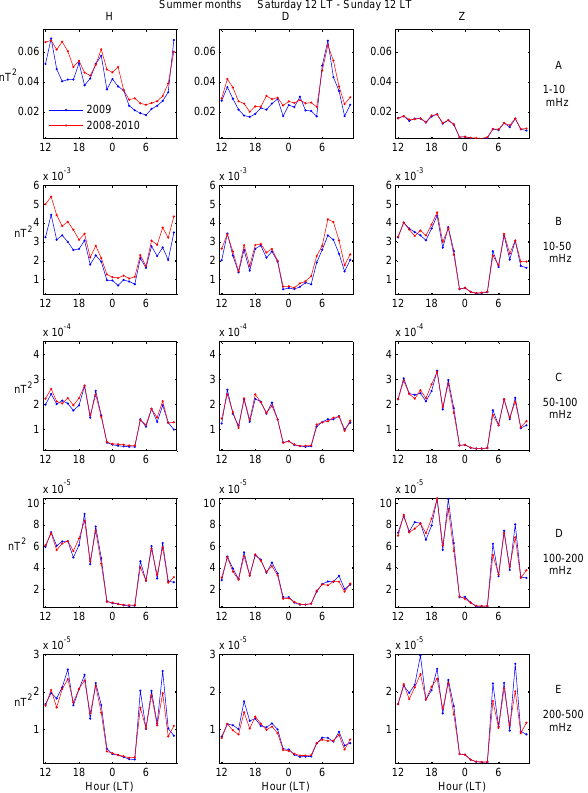
Figure 6. The same as in Fig. 5 but for the weekend (Saturday 12:00LT–Sunday 12:00LT).